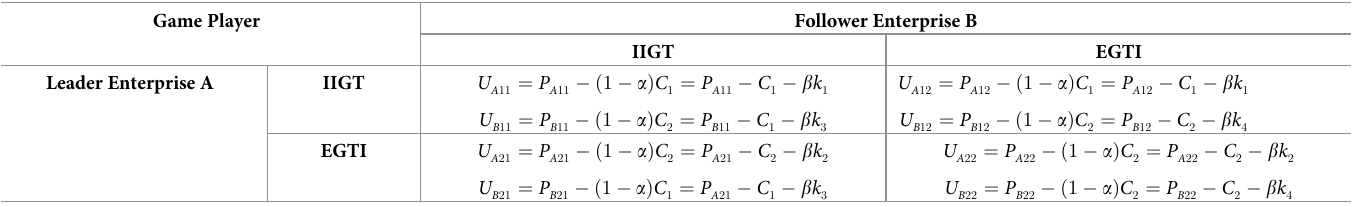
Table 1. Payment matrix of duopoly game under environmental regulation. Game